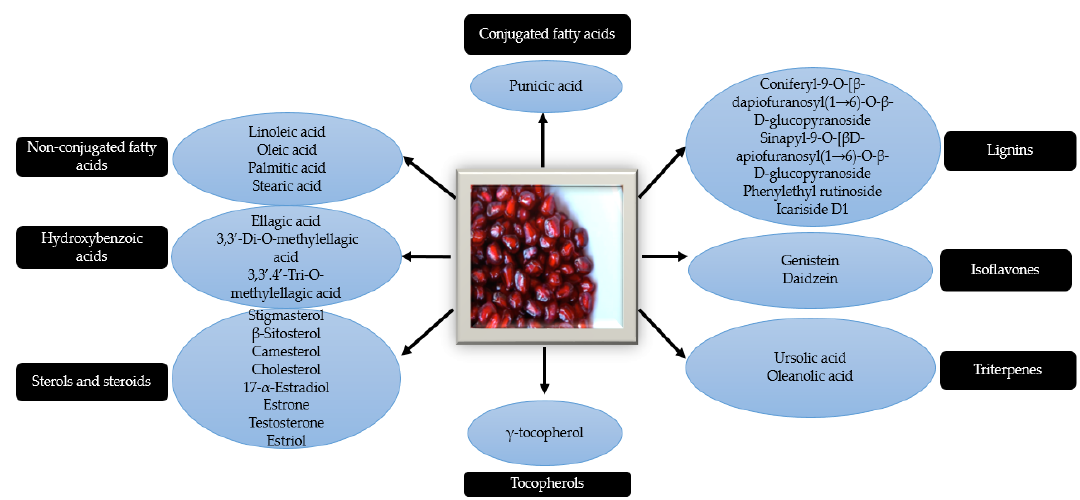
Figure 4. Chemical composition of the pomegranate seeds.